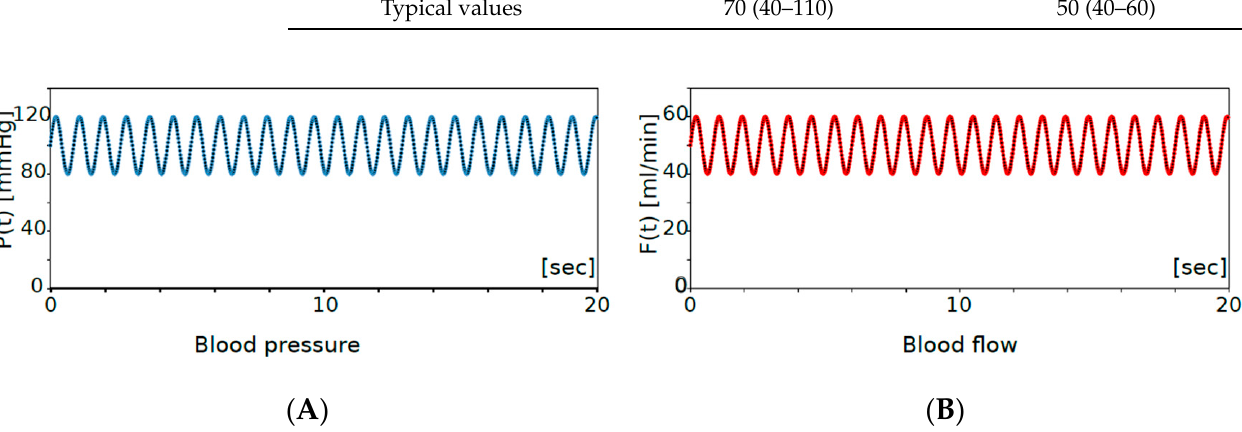
Figure 2. Blood flow F ( t ) and blood pressure P ( t ) in the main vessel are given in the left panel ( A ) and the right panel ( B ), respectively. Environmental variables are determined by the heartbeat: blood pressure P ( t ) and blood flow F ( t ) are plotted for 0–20 s. These are regularly provided by the heart. The time periodic oscillation is fixed by the typical beat 70 bpm (Table 1), the blood pressure is assumed to range from 80 to 120 mmHg and the blood flow to be 40 to 60 mL/min.